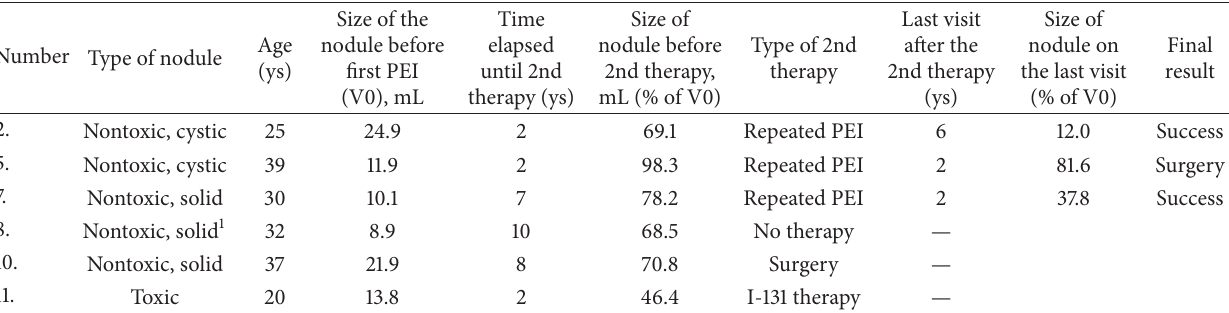
Table 3: The fate of patients with unsuccessful PEI